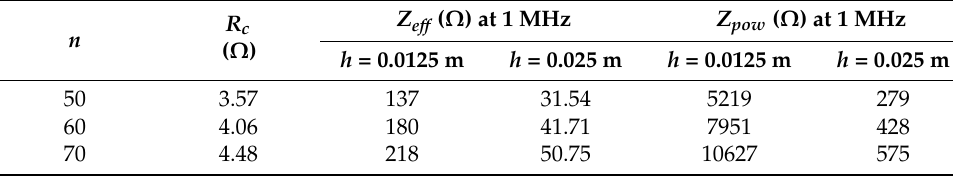
Table 3. Calculated circuit parameters for r = 0.025 m (without skin